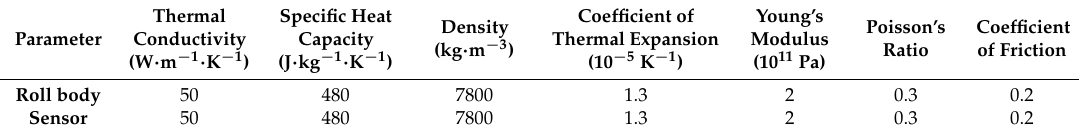
Table 2. Material properties of the shapemeter roll.